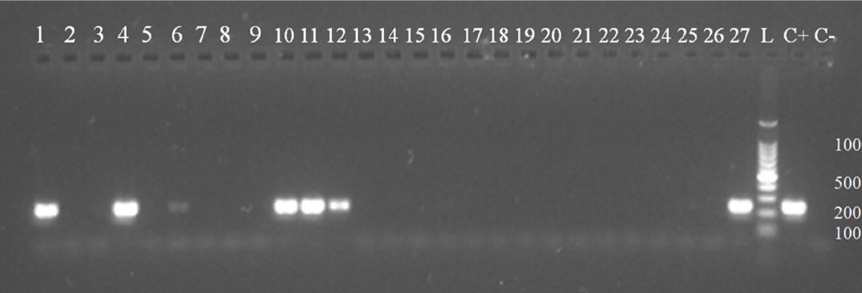
Figure 1. Electrophoresis on 1.5% agarose gel of the Rickettsia spp. PCR (246 bp). Lines 1–27: DNA from flea samples. Lane L: 100 bp ladder. Lane C + : positive control. Lane C-: negative control.